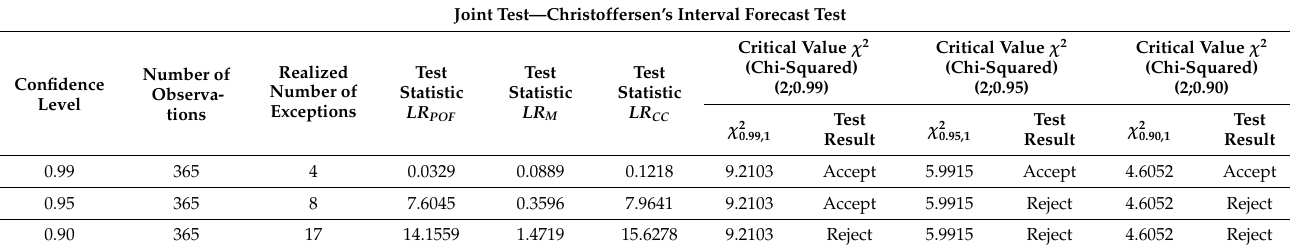
Table 13. Monte Carlo simulation VaR Christoffersen’s Interval Forecast test. Joint Test—Christoffersen’s Interval Forecast